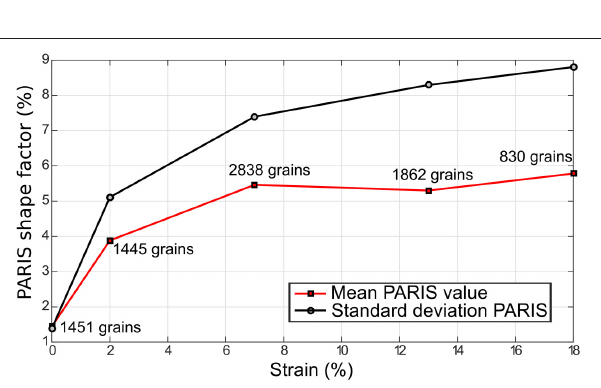
FIGURE 4 | Evolution of the PARIS shape factor (%) with deformation for the tests performed at − 5 ◦ C, evaluated as the mean over all grains. The curve of the standard deviation is also shown